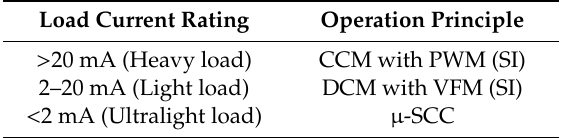
Table 1. Operation regions of the triple mode SIC dc-dc buck